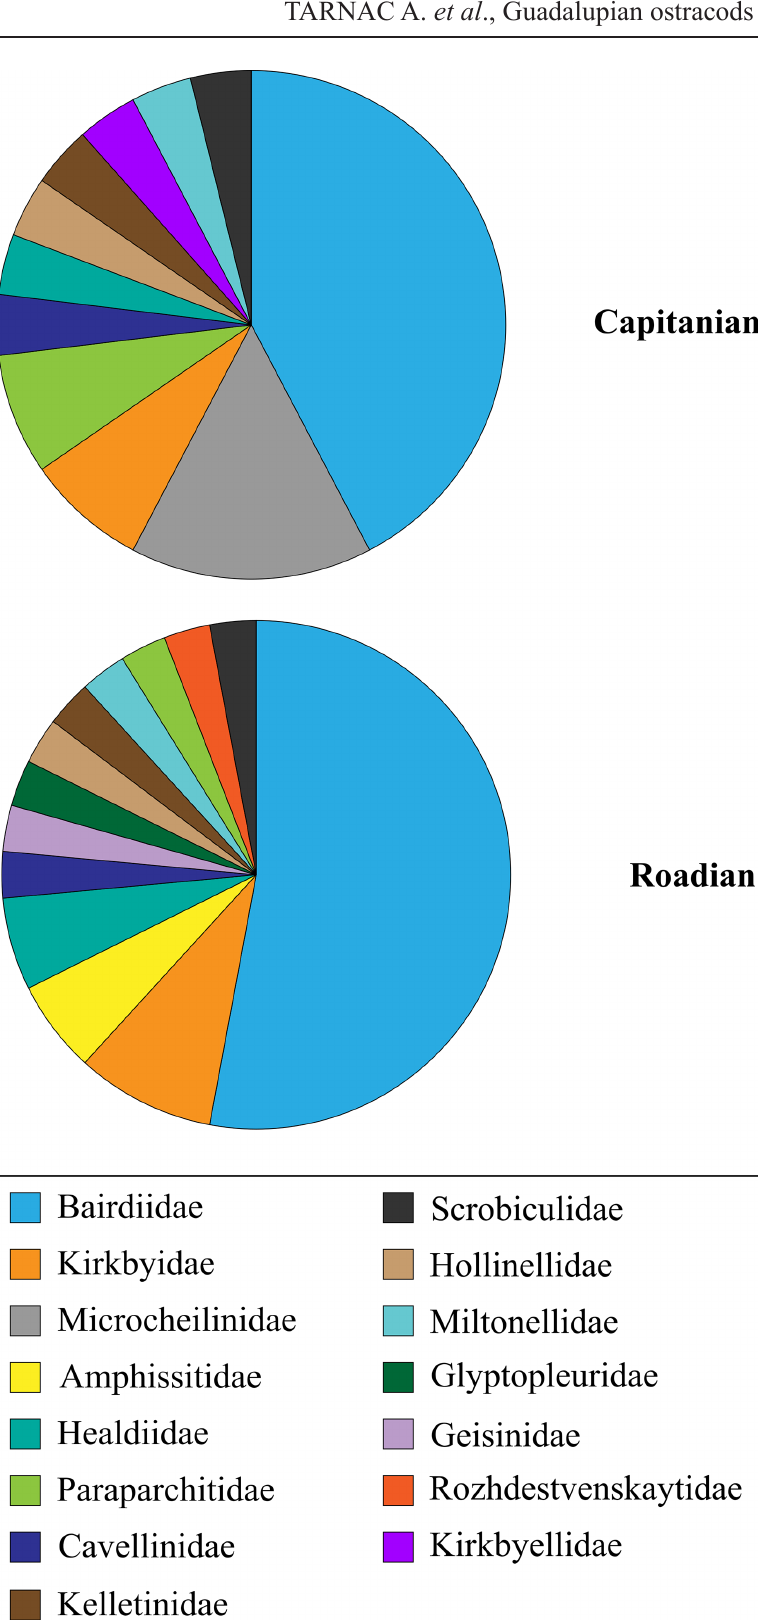
Fig. 12. Circular diagrams of faunal composition of ostracod assemblages by number of species in the Roadian and Capitanian of the Guadalupe Mountains, West Texas,